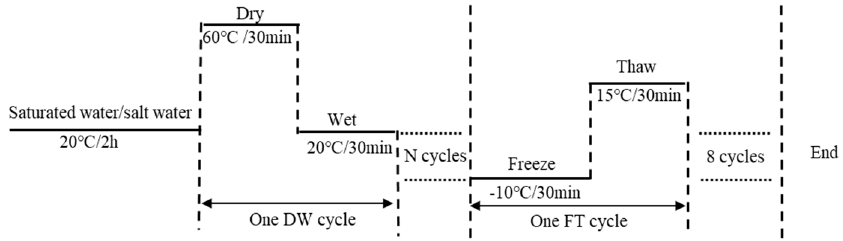
Figure 1. Schematic of the salt “dry–wet and freeze–thaw” (DW-FT) cycles for the mastics: N = 8, 15, and 25.